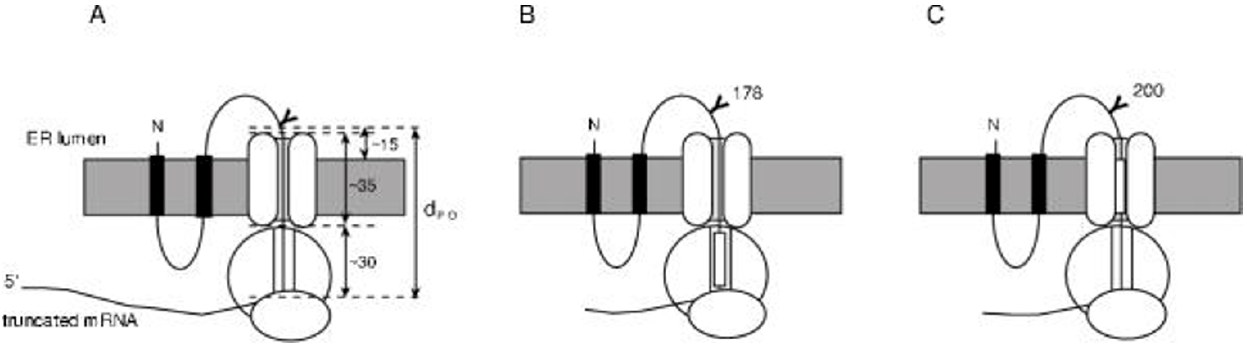
Figure 1 Determination of the minimum number of residues required to span the distance between the ribosomal P-site and the active site of oligosaccharide transferase (d P-O values). Ribosome-bound truncated nascent chains of different lengths are generated by in vitro translation, in the presence of dog pancreas microsomes, of mRNAs lacking a stop-codon. The d number of residues between the Asn residue in an Asn-Ser-Thr glycosylation acceptor site ( Y ) and the C-terminal end of the nascent chain required for half-maximal glycosylation of the acceptor site. (A) The model protein used in this study ( E. coli Lep) has two transmembrane segments (black) and a C-terminal lumenal domain. The approximate number of residues in an extended chain needed to span the indicated distances are given [10]. (B) Truncated Lep with a model segment (white) placed in the ribosome. The glycosylation site is placed in position 178 in Lep. (C) Truncated Lep with a model segment (white) placed in the translocon. The glycosylation site is placed in position 200 in Lep. In both panels B and C, the model segment is intro- duced between positions 214 and 220 in